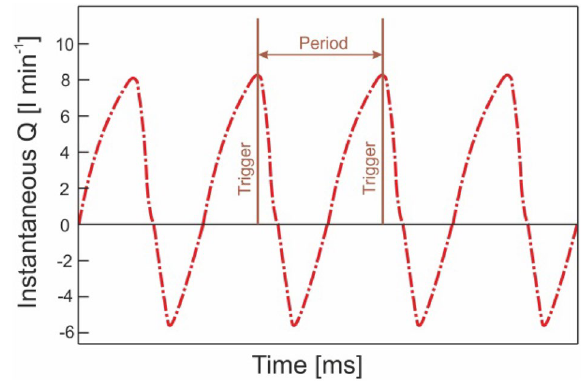
Figure 4. Software trigger for triggering closure of the pincher.